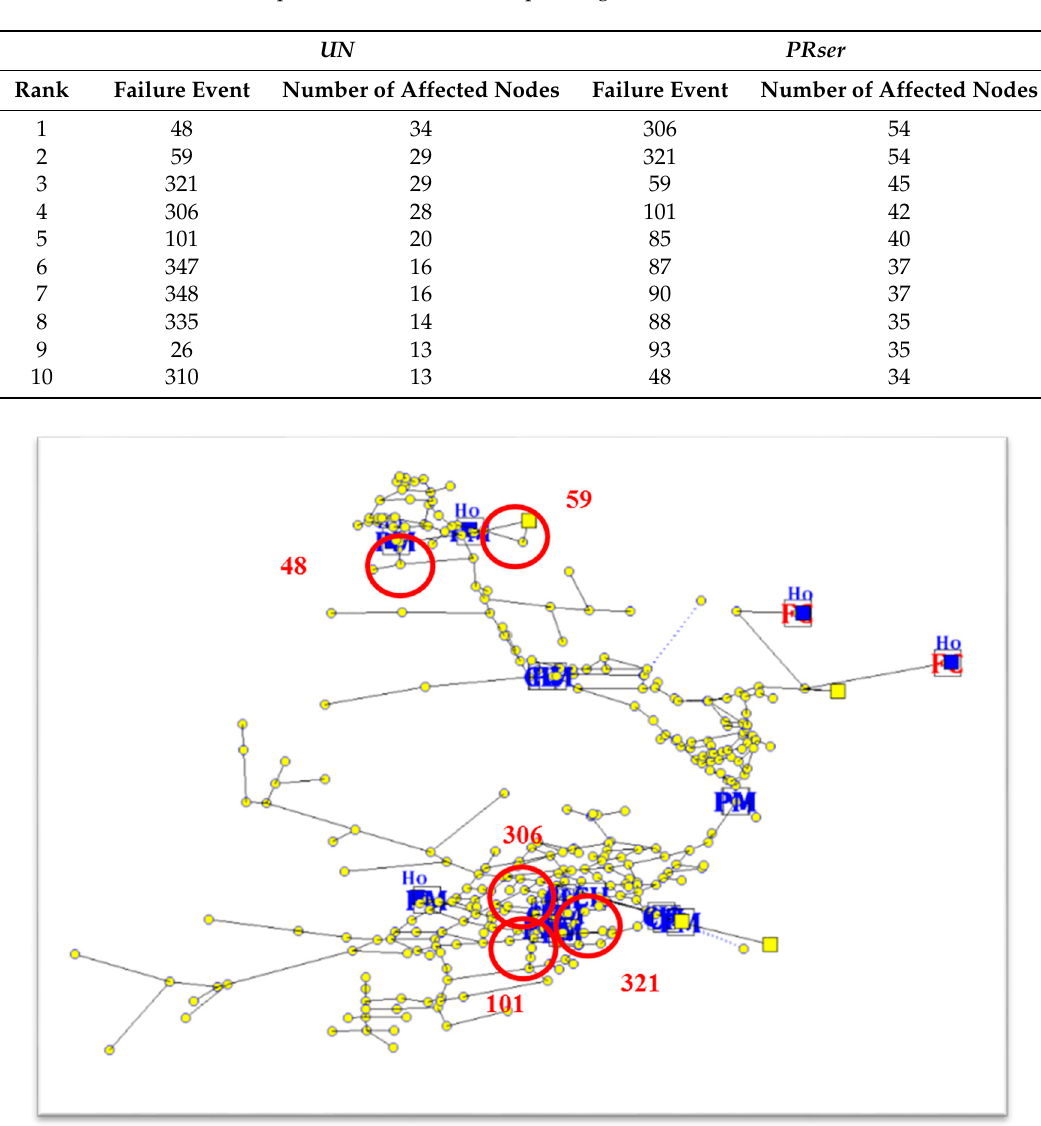
Figure 8. Locations of the five common failure events in Laives water distribution network.